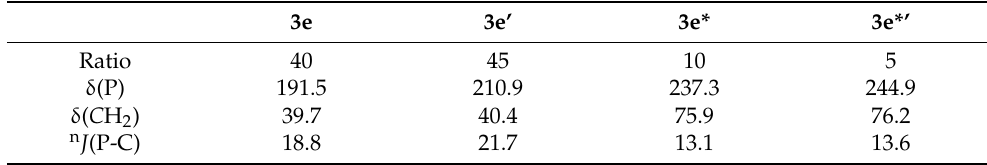
Table 3. Selected NMR spectroscopic data of 3e,e’ and 3e*,e*’ , measured in the reaction solution, chemical shifts in ppm, and coupling constants in Hz.